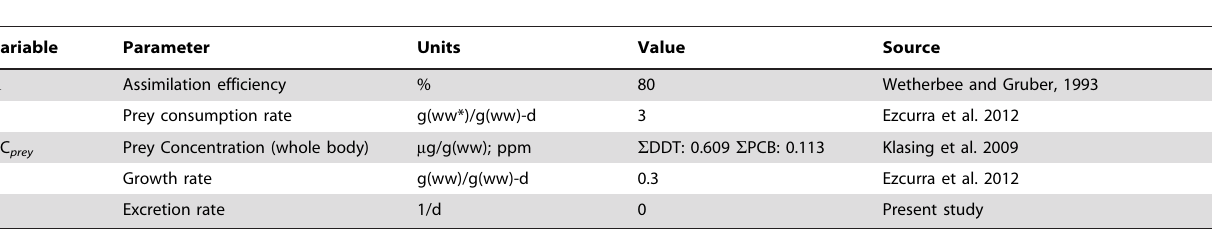
Table 2. Parameter values used to simulate dietary bioaccumulation over 365 days.